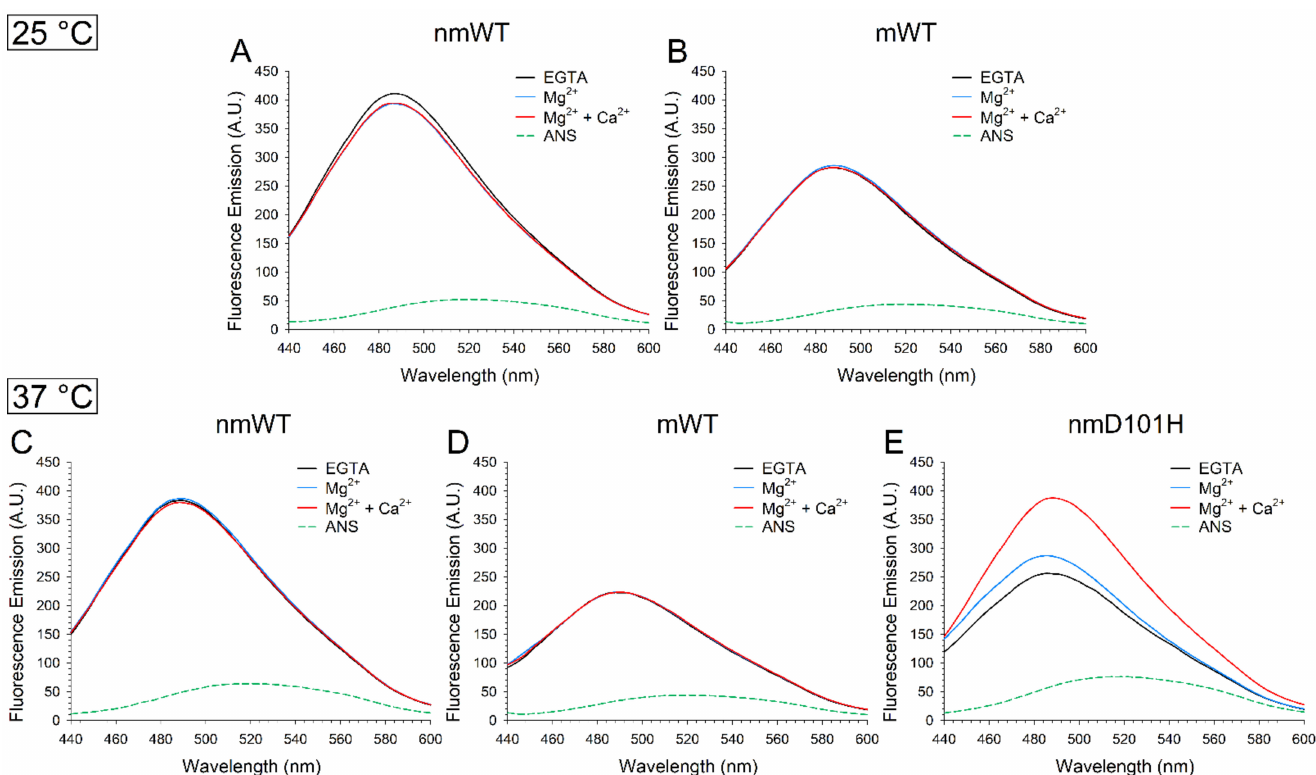
Figure 8. Fluorescence spectra of 30 µ M ANS and 2 µ M nmWT, mWT and nmD101H GCAP3 in the presence of 500 µ M EGTA (black) and after sequential additions of 1 mM Mg 2+ (blue) and 1 mM Ca 2+ (red), leading to approximately 500 µ M free Ca 2+ . Data were collected at 25 ◦ C (upper panels) and 37 ◦ C (lower panels). Fluorescence spectra recorded at 25 ◦ C of 30 µ M ANS and ~2 µ M ( A ) nmWT; and ( B ) mWT GCAP3 in the presence of 500 µ M EGTA (black) and after sequential additions of 1 mM Mg 2+ (blue) and 1 mM Ca 2+ (red), leading to approximately 500 µ M free Ca 2+ . Fluorescence spectra recorded at 37 ◦ C of 30 µ M ANS and ~2 µ M ( C ) nmWT; ( D ) mWT; and ( E ) nmD101H GCAP3 in the same experimental conditions as